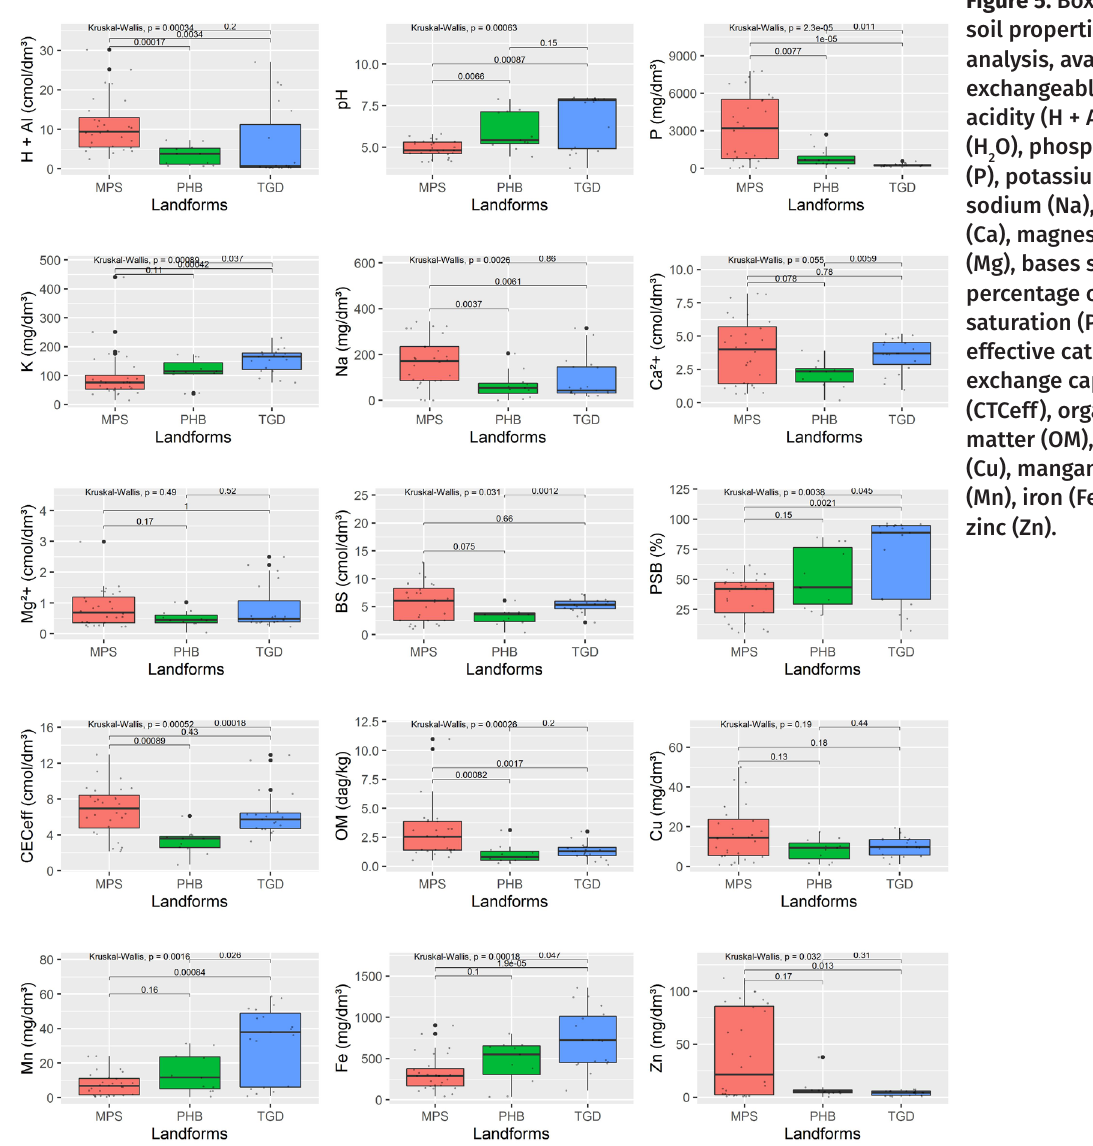
Figure 5. Boxplots soil properties.